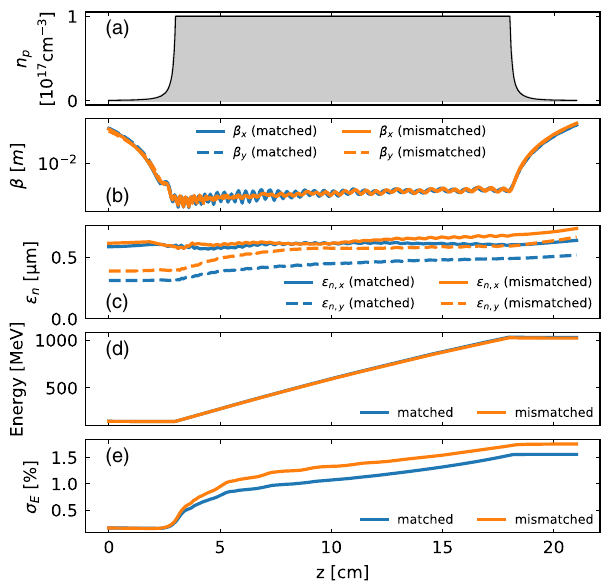
FIG. 8. Simulated evolution of beam parameters through an LPA plasma cell, using FBPIC code, in the ARES linac for the matched beam and the mismatched case 1 beam considered in this